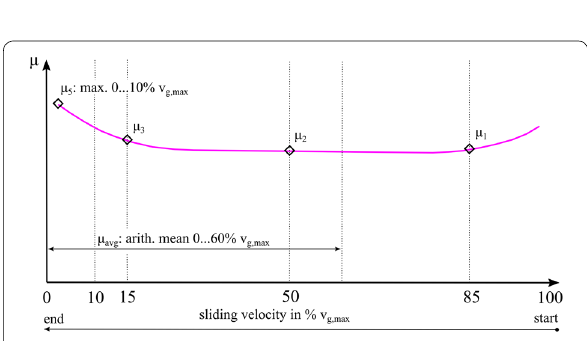
Figure 7 Sample friction characteristic with characteristic friction values